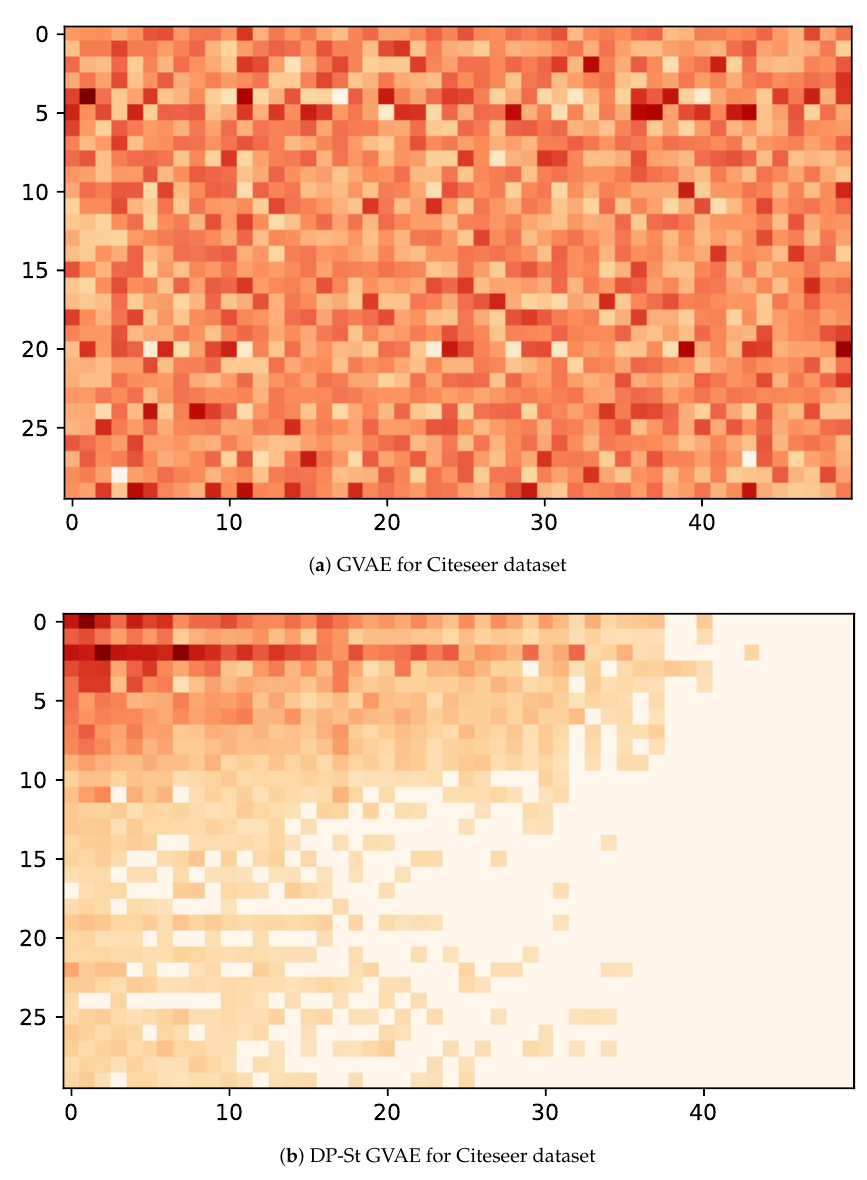
Figure 5. Latent representation visualization for Citeseer dataset. The horizontal axis is the dimension of the hidden variable, and the vertical axis is the number of nodes. ( a ) the latent variable learned by GVAE. ( b ) the latent variable learned by DP-St GVAE. The darker the higher probability nodes possess the latent